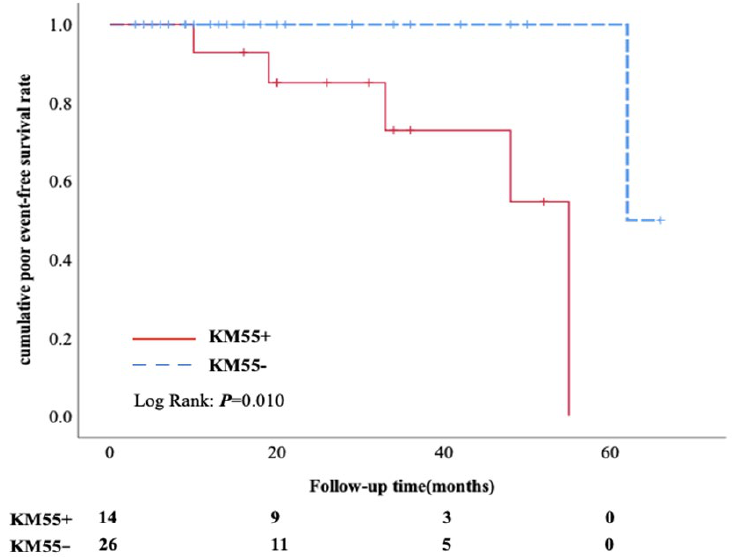
Figure 6. Kaplan-Meier analysis. Cumulative poor event-free renal survival rate between the KM55+ and KM55- subgroups.